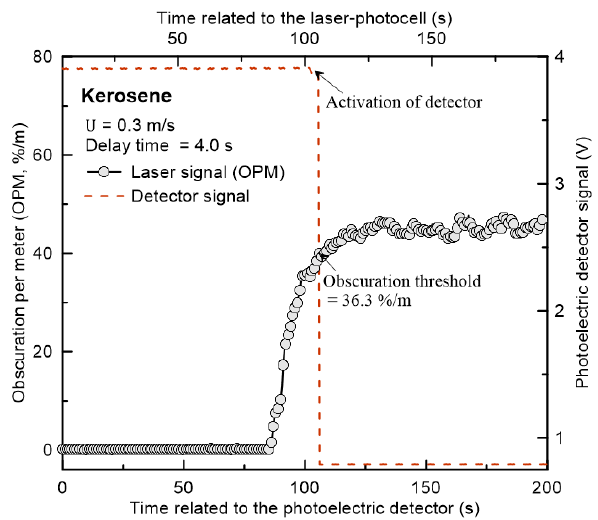
Figure 3. Procedure for measuring the obscuration threshold of smoke detector using FDE.